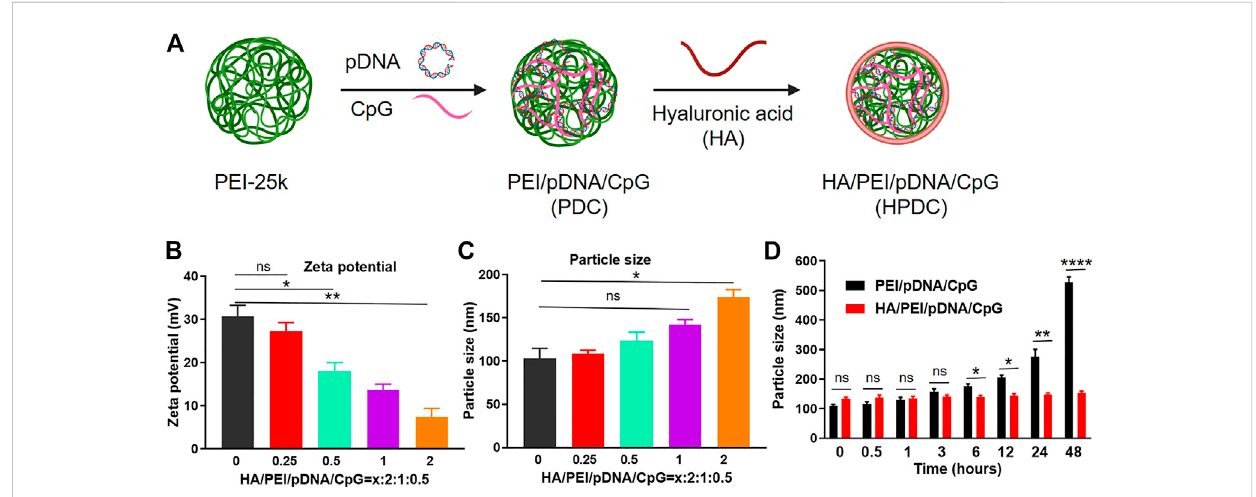
FIGURE 1 PreparationandcharacterizationofHA/PEI/pDNA/CpGnanoparticles. (A) PreparationrouteofHA/PEI/pDNA/CpGnanoparticles. (B) Zetapotentials and (C) particle sizes of HA/PEI/pDNA/CpG nanoparticles at different mass ratios. (D) Stability of HA/PEI/pDNA/CpG nanoparticles in FBS solutions at different incubation time points. ns = no signi fi cance, * p < 0.05, ** p < 0.01, **** p < 0.0001.